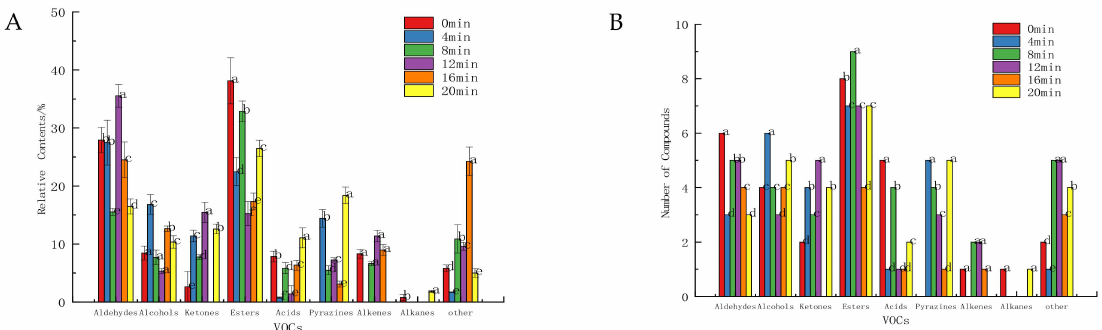
Figure 1. Relative content ( A ) and number ( B ) of VOCs in defatted tiger nut flour. Different lowercase letters in the same classification indicate that there was a significant difference ( p <